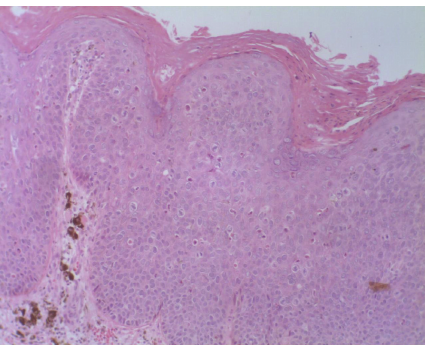
Figure 2: Case 1. H&E shows pBD with parakeratosis and marked acanthosis consisting in atypical keratinocytes on all levels of the epidermis, dilated capillary vessels, and grouped melanophages only in the papillary